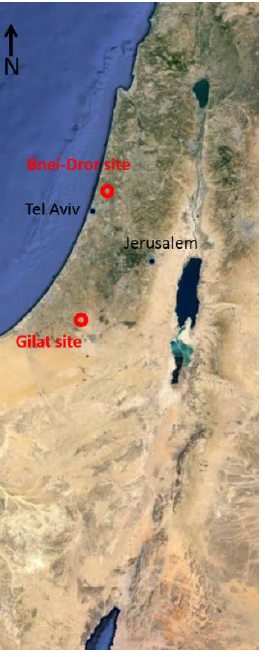
Figure 1. Map of Israel with the research sites marked with red circles